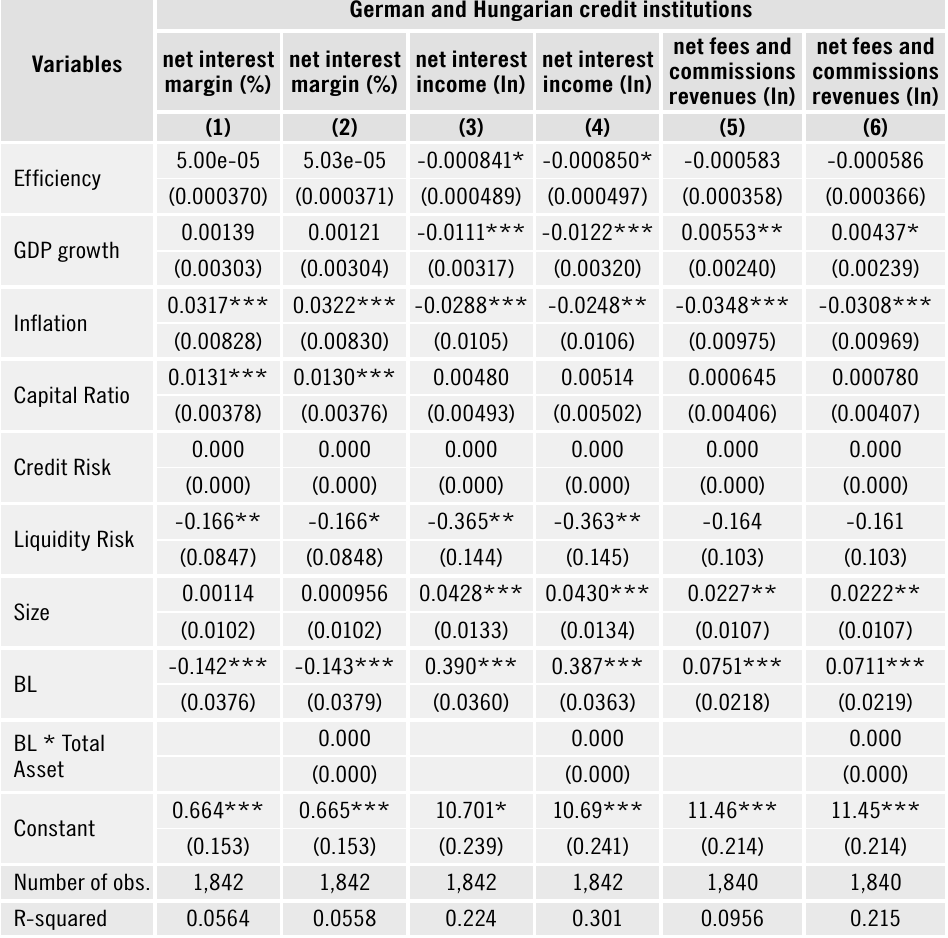
Table 6. Data presenting estimates based on GLS regressions with a random effect on German and Hungarian credit institutions between 2005 and 2015. Data have been sourced from unconsolidated financial statements. Institution-specific characteristics appear as one-year lagged variables in all specifications. The bank levy (BL) is represented by a dummy variable indicating 1 for all years the levy applies to, and zero for all remaining years. Robust standard errors that control for clustering at the financial institution level are reported in